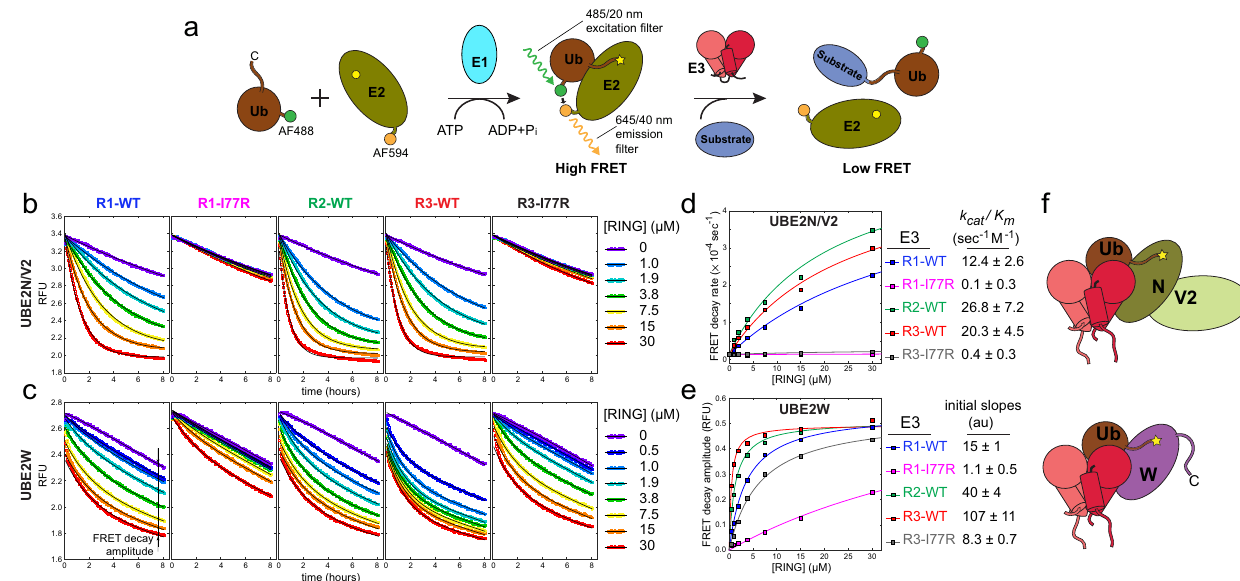
Fig. 3 | ThecontributionofRING dimerizationto thecatalytic enhancement of ubiquitin discharge from the UBE2N~Ub and UBE2W~Ub conjugates can be quanti fi edusinga FRET ubiquitin discharge assay. a A cartoon schematicofthe FRET ubiquitin discharge assay used in this study. b Kinetics of RING-catalyzed ubiquitin discharge from the heterodimeric UBE2N~Ub/V2 (0.1 µ M) is well approximated by an exponential decay function in agreement with the Michaelis- Menten equation (Supplementary Methods). c In contrast, ubiquitin discharge from UBE2W~Ub (0.1 µ M) is not well described by the Michaelis-Menten model. d UBE2N/V2 ubiquitin discharge rates are plotted against RING concentration and